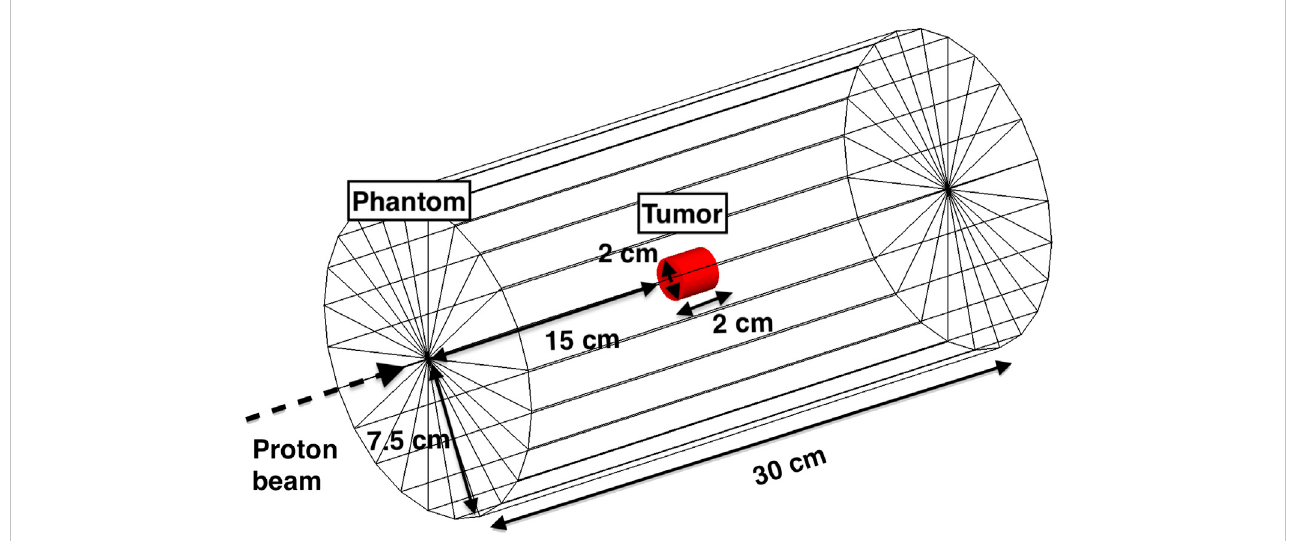
FIGURE 4 Setup used for all TOPAS MC simulations to investigate the correlations between the number of signature PGs and the proton range. The geometry is composedofanoutercylindermadeofsofttissue,andatumorregion(redcylinder)locatedatadepthof15 cmfromtheentrance.Theenergiesoftheproton beam ranged between 145 MeV and 165